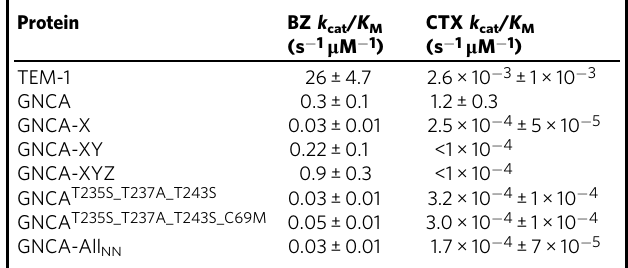
The experimental data are provided as a Source Data raw_rates fi